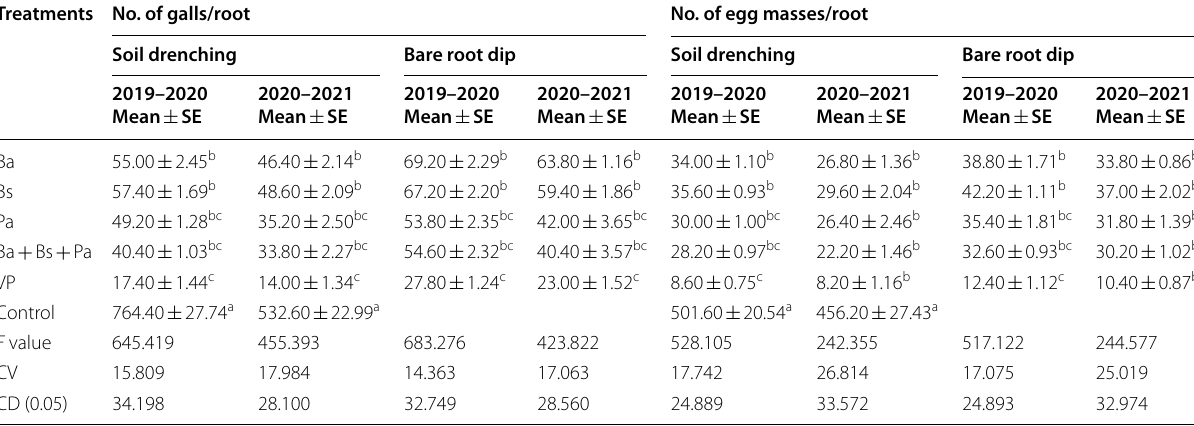
Data shown correspond to the mean of four replicates SE. Means with the same alphabet letters on each columns are not significantly ( P < 0.05 ) different ± CD critical difference, CV coefficient of variation, SE standard error. Treatment details: Ba Bacillus amyloliquefaciens DSBA 11, Bs Bacillus subtilis DTBS 5, Pa Pantoea agglomerans ; Ba Bs Pa (Consortium), VP Velum Prime ® (500 g a.i./ha) as positive control + +